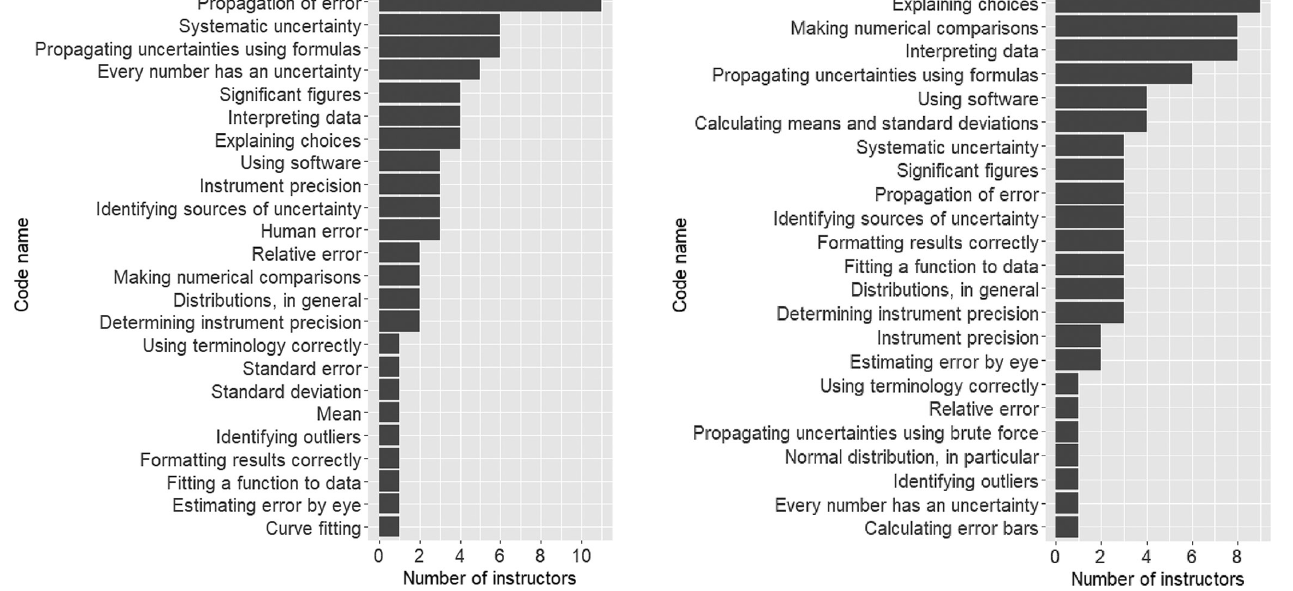
FIG. 5. The number of interviews ( N structors mentioned topics students find difficult, broken down by the emergent codes in Tables IV and V.